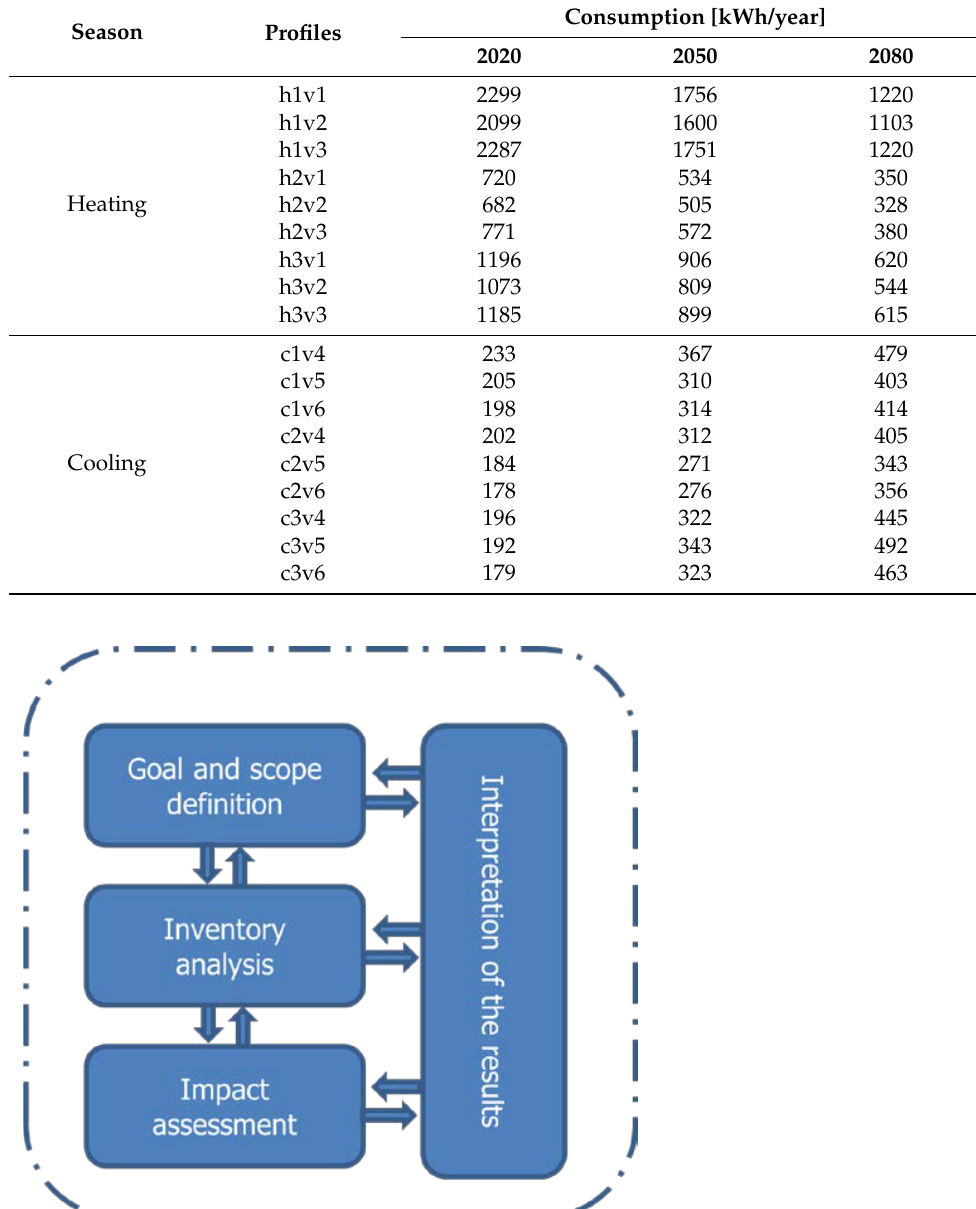
Table 6. Energy consumption [kWh/year] for heating and cooling with setpoint temperatures of 20 ◦ C (heating) and 26 ◦ C (cooling).